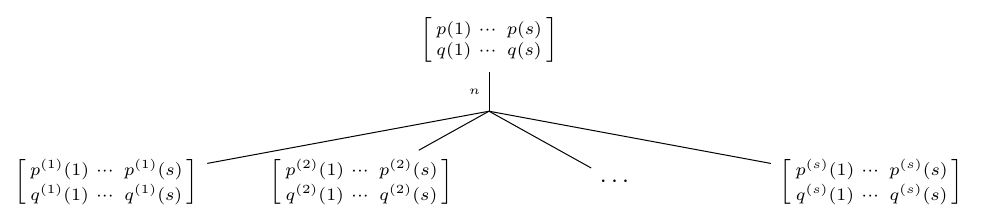
Figure 2: A vertex and its s descendants in the stage